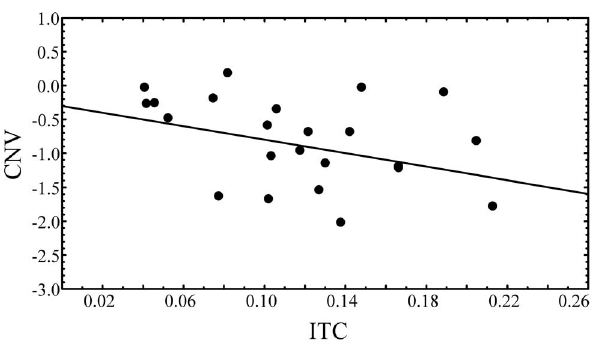
Figure 6. Correlation between ITC and CNV. CNV (in m V) values as a function of coherence (ITC) in the 2 Hz condition. The solid line indicates the regression line.